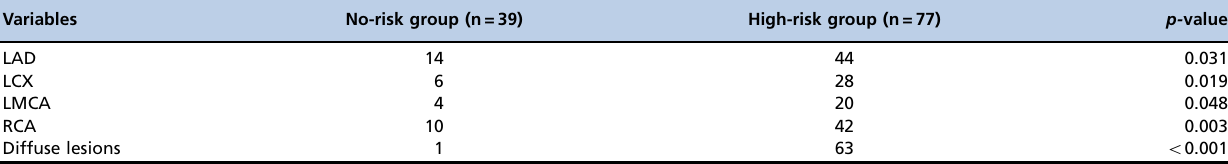
Table 2 - Lesions of the LMCA, LAD, LCX, and RCA between the two groups.